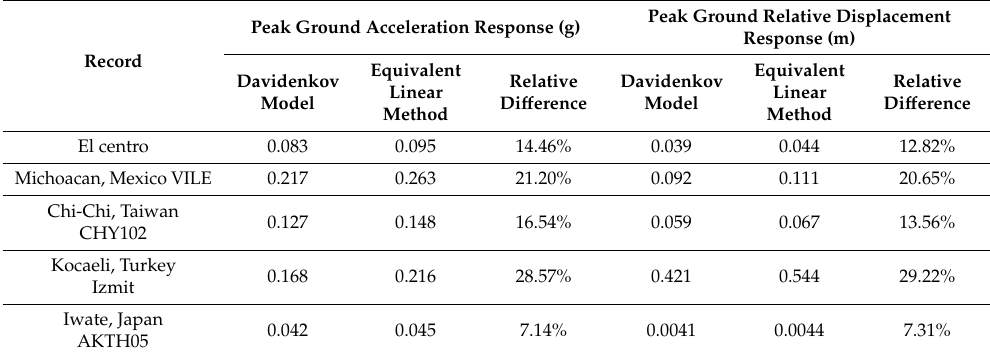
Table 2. Comparison between the Davidenkov model and equivalent linear method results.